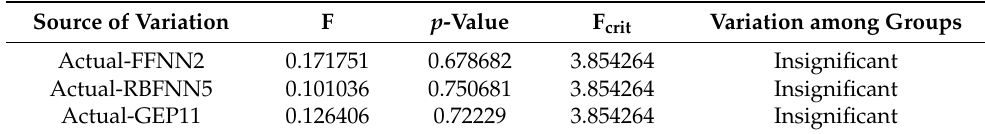
Table 9. Single-factor ANOVA results for the best combination of inputs. Table 10. Statistical criteria for the best combination of inputs.